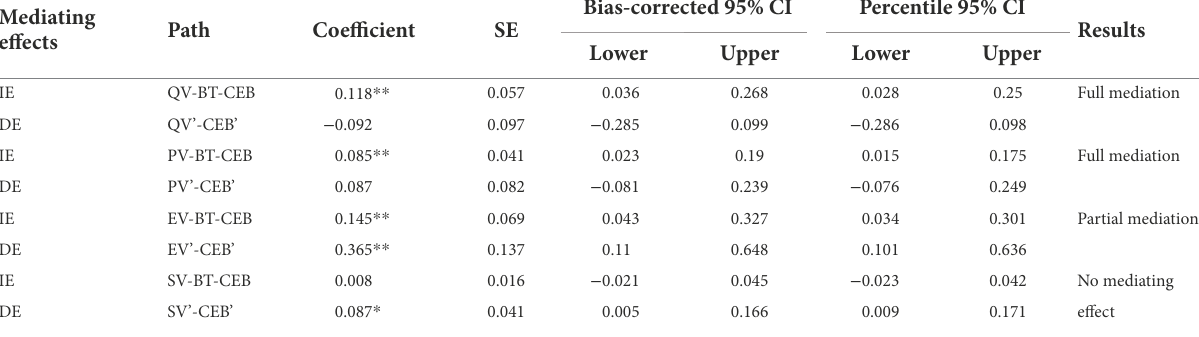
TABLE 4 Hypothesis testing results of mediating